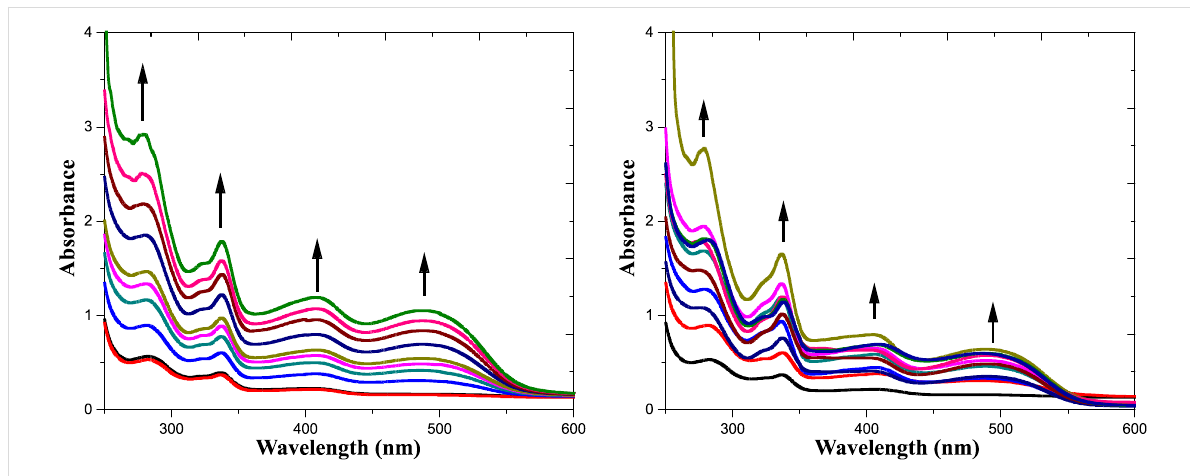
Figure 4: UV spectral change of receptor 1 ( c = 1.1 × 10 −4 M) upon gradual addition of [Bu 4 N] + F − (left side) and [Bu 4 N] + AcO − (right side) in CH 3 CN/ H 2 O (4:1 v/v) ( c = 1.1 × 10 −4 M).